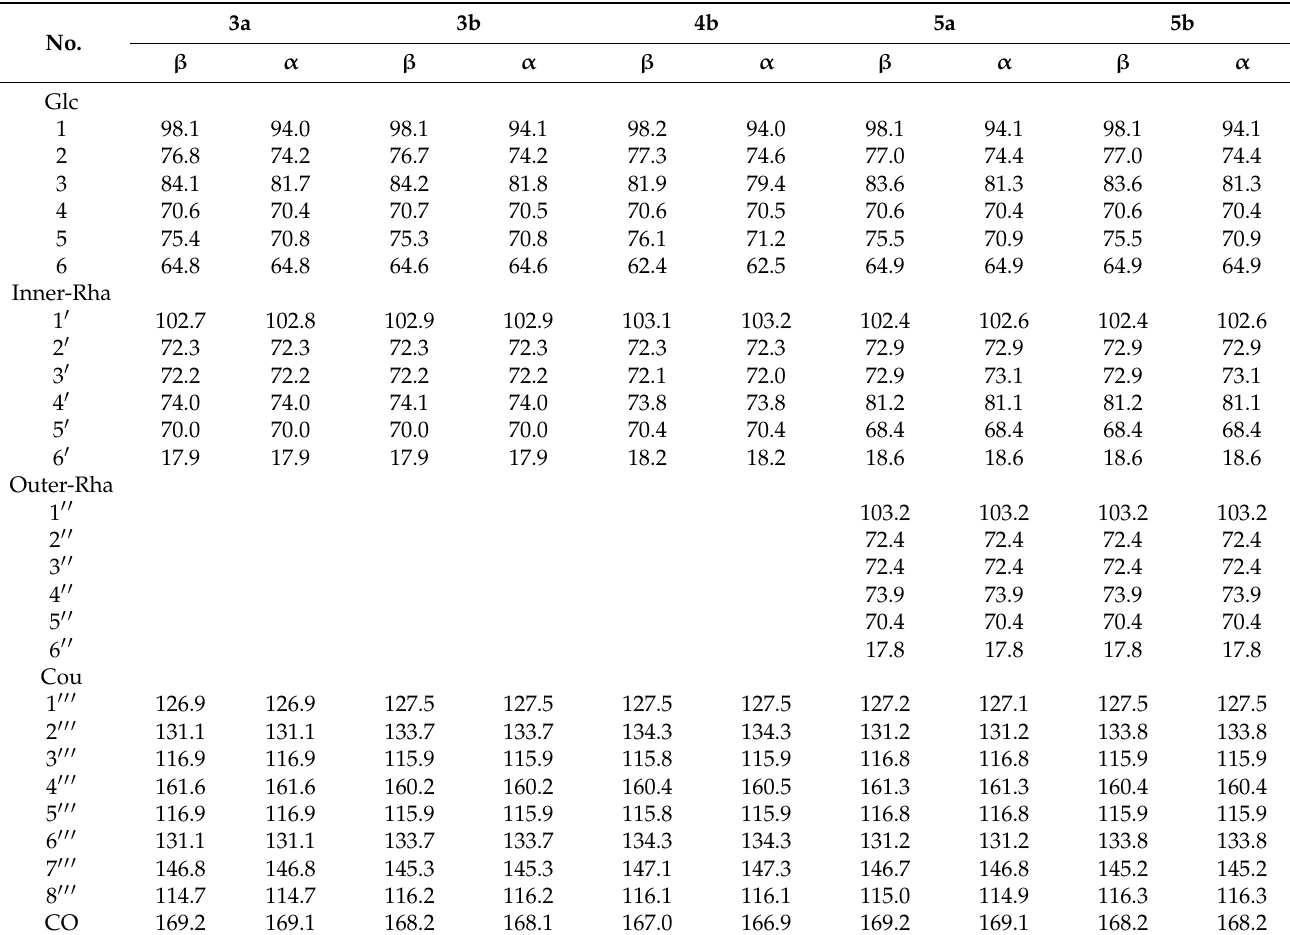
Table 4. 13 C NMR (100 MHz) data of compounds 3 - 5 from L. robustum in CD 3